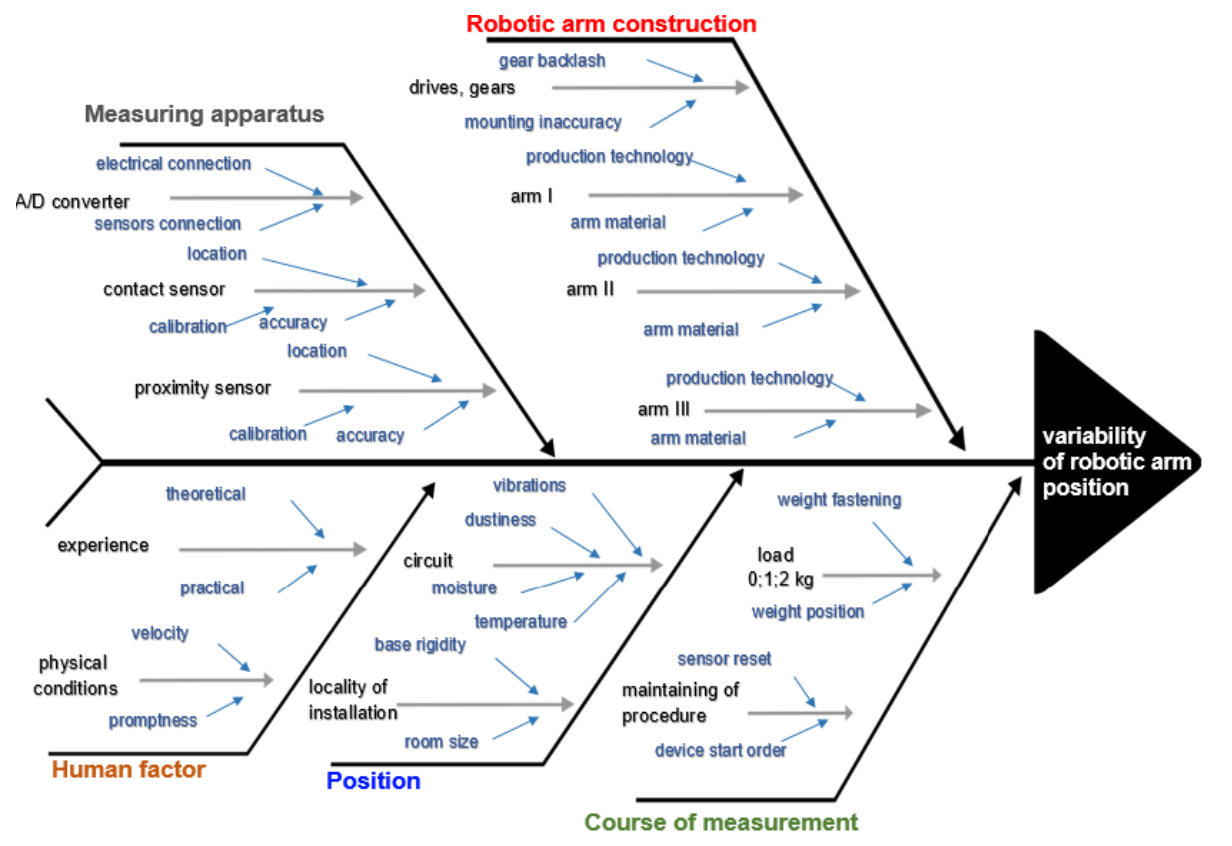
Figure 10. Causes and effects diagram.